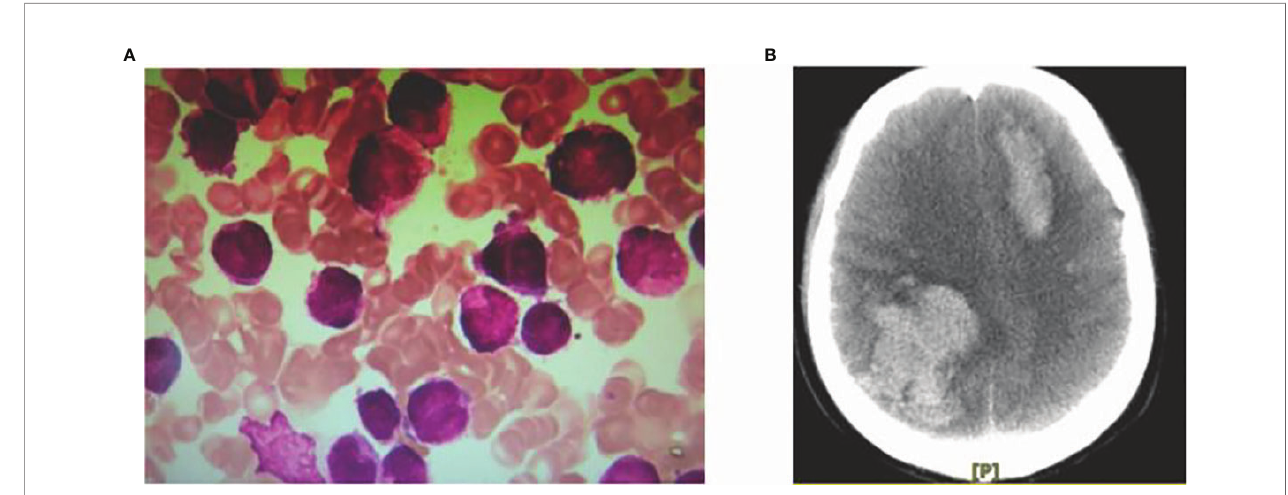
FIGURE 1 | Myeloid morphology (A) and CT signs of intracranial hemorrhage in acute promyelocytic leukemia (B)